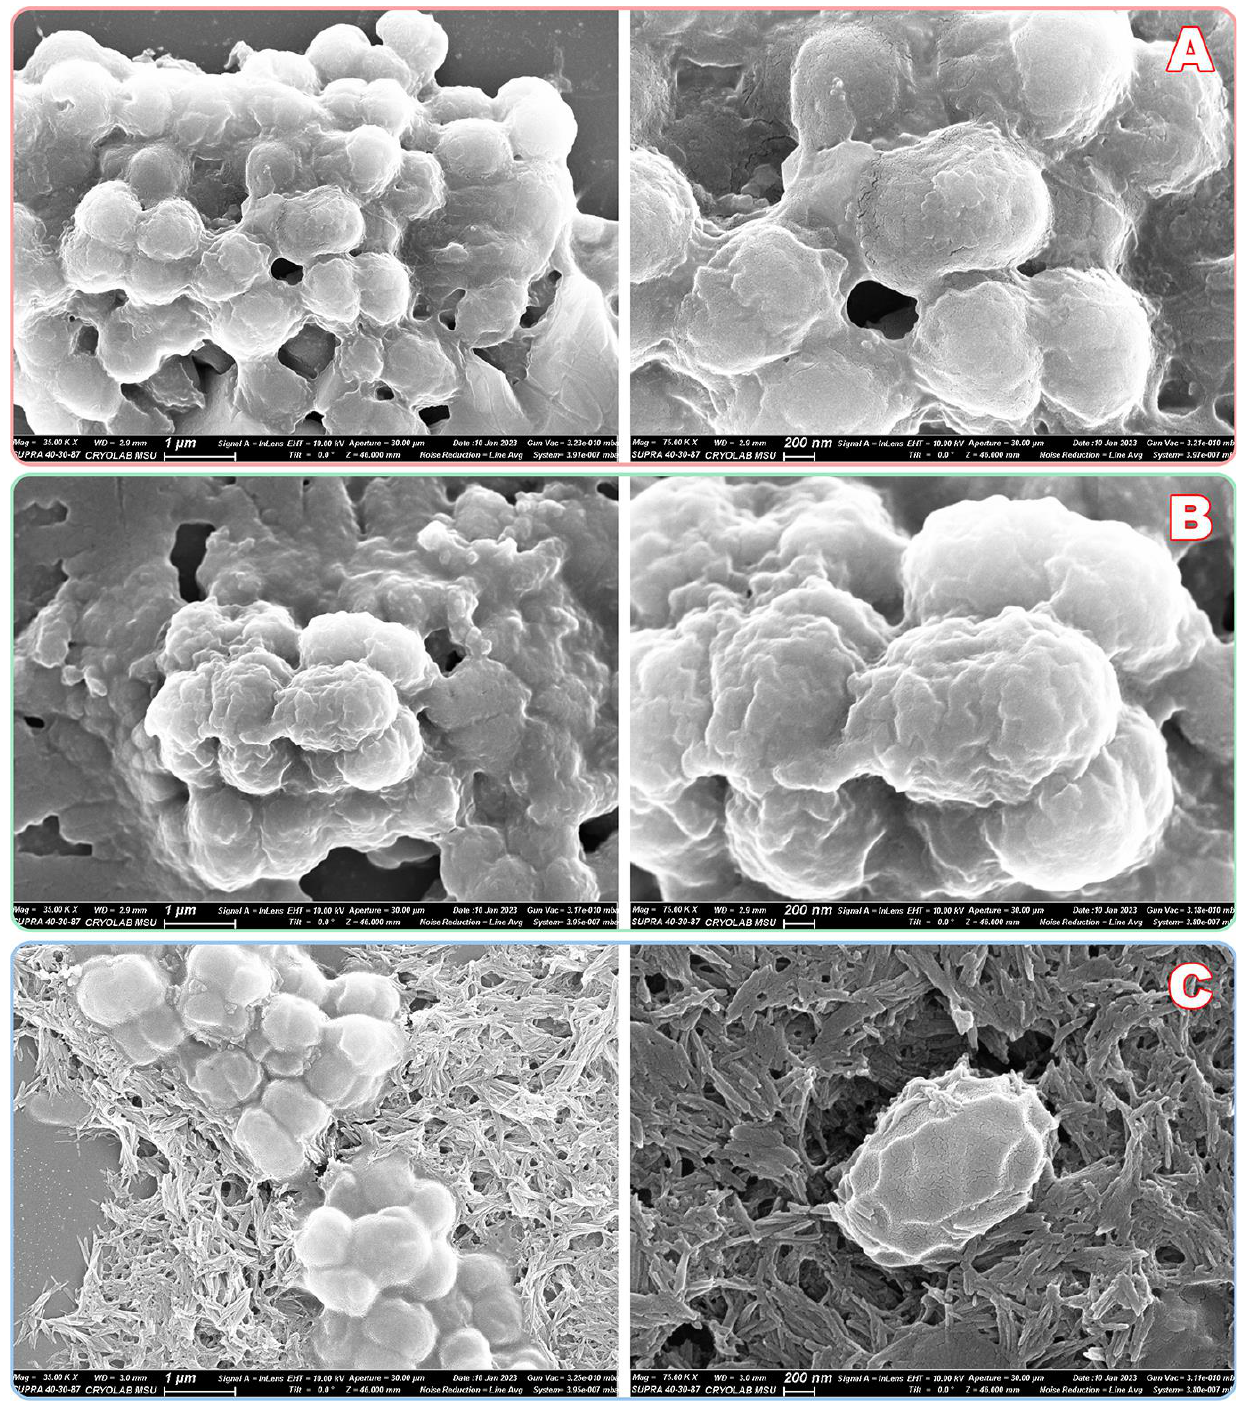
Figure 8. SEM analysis of E.coli cells after exposure at 25 °C for 3 h in PBS buffer: control ( A ); NCs of emodin with His 6 -OPH and penicillin acylase ( B ); the same NCs together with polymyxin B ( C ). Cells were treated in suspension and then applied to APS-modified silicon wafers, dried and sputtered by gold.